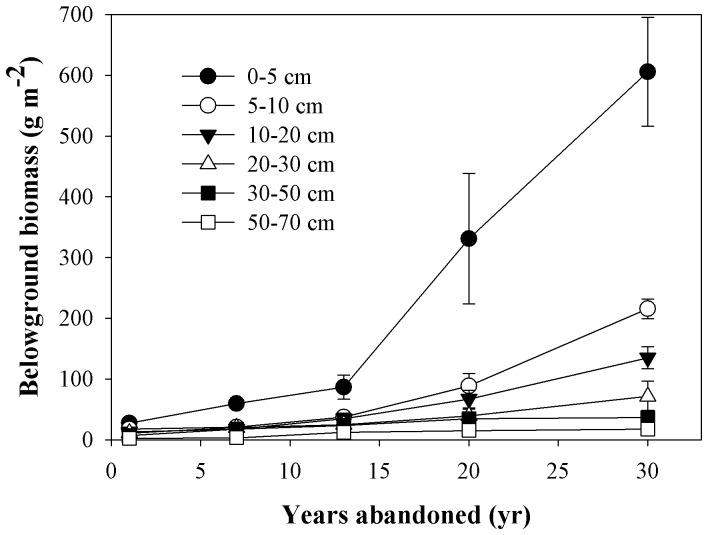
Dynamics of belowground biomass in 0–100 cm soil depth following the conversion of farmland to grassland.Values are in the form of Mean ± SE and the sample size n = 5. It didn't have roots in the 70–100 cm soil layers.